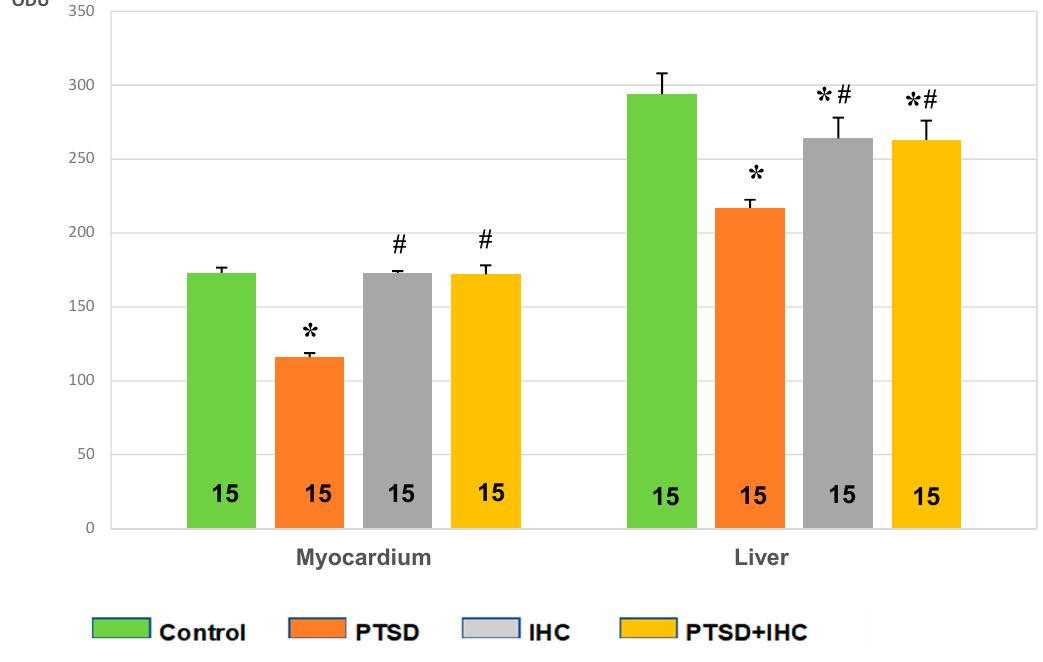
Figure 1. E ff ect of PTSD, IHC, and PTSD + IHC on glycogen content in the rat heart and liver. ODU = optical density units. PTSD = posttraumatic stress disorder; IHC = intermittent hypoxic conditioning. Data are presented as means ± SEM. Number of rats in groups is shown on the bars. * Significantly di ff erent from control; # significantly di ff erent from PTSD. Specific p values are stated in the text.